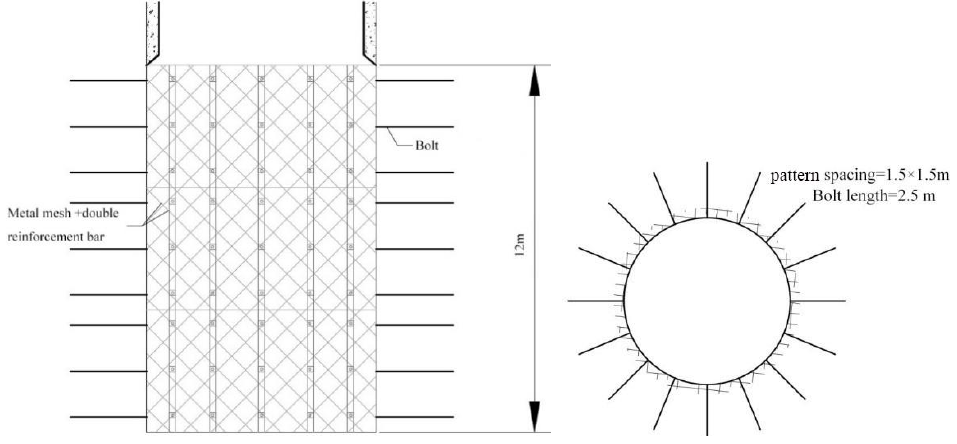
Figure 7. Scheme of primary support.